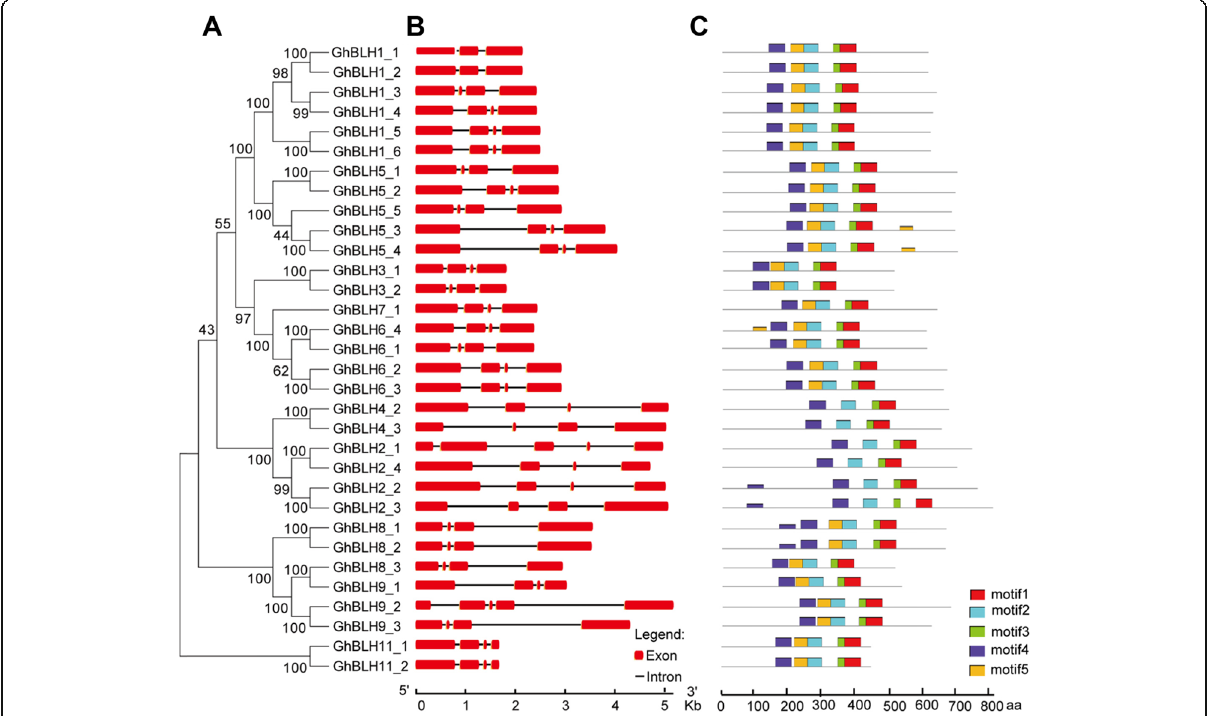
Fig. 3 Phylogenetic tree, gene structure, and motif composition of the G. hirsutum BLH genes. a The phylogenetic tree was constructed using MEGA 6.0 with the neighbor-joining (NJ) method and 1 000 bootstrap replicates. b Exon and intron structure of BLH genes from G. hirsutum . The introns and exons are represented by black lines and red boxes, respectively. c Protein motifs. Each motif is represented using colored